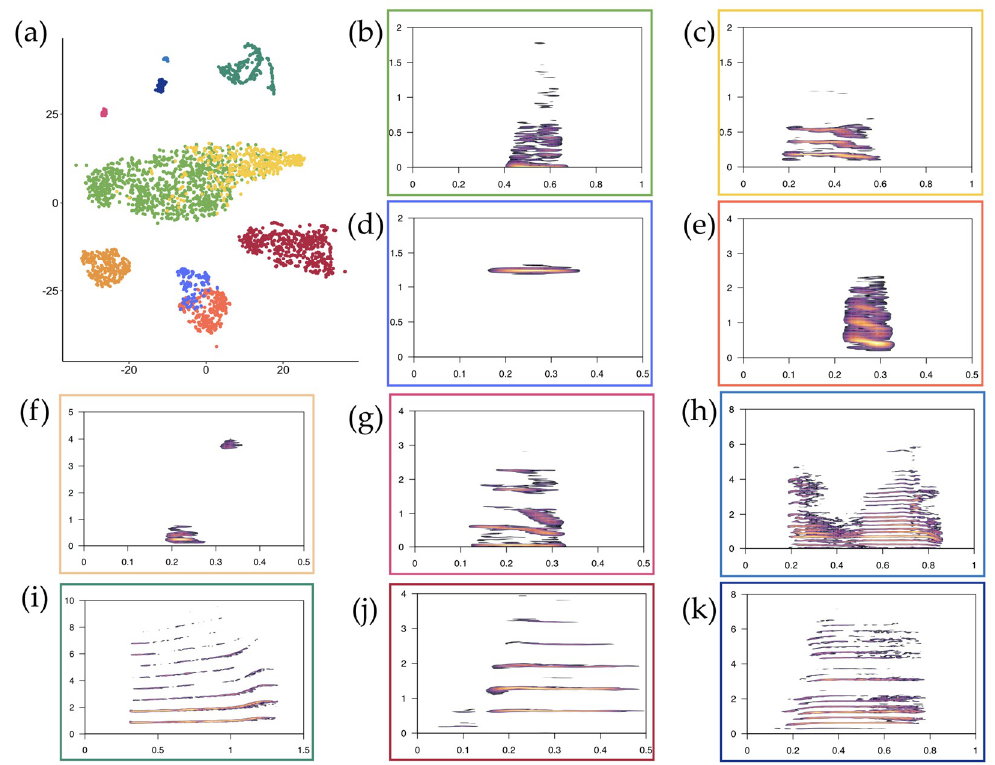
Figure 2. ( a ) Distribution of the vocal types in the clouds identified by the t-SNE map and their spectrographic representation: ( b ) Grunt, ( c ) hum, ( d ) wheeze, ( e ) kiss, ( f ) wheezing grunt, ( g ) short tonal call, ( h ) long tonal call, ( i ) songbit, ( j ) clacson, and ( k ) roar. Almost all classes (except kisses and wheezes and hums and grunts) were well separated. Spectrograms—frequency (kHz) on the y-axis and time (s) on the x-axis—were obtained with a Hanning window, 512 samples, 0% overlap, and no zero-padding using the Seewave package [48,49]. Table 1. Distribution of the vocal types in the eight clusters (expressed in %). Cl: clacsons; GR: grunts; GRH: wheezing grunts; HU: hums; KI: kisses; LT: long tonal calls; RO: roars; SB: songbits; ST: short tonal calls; WH: wheezes.